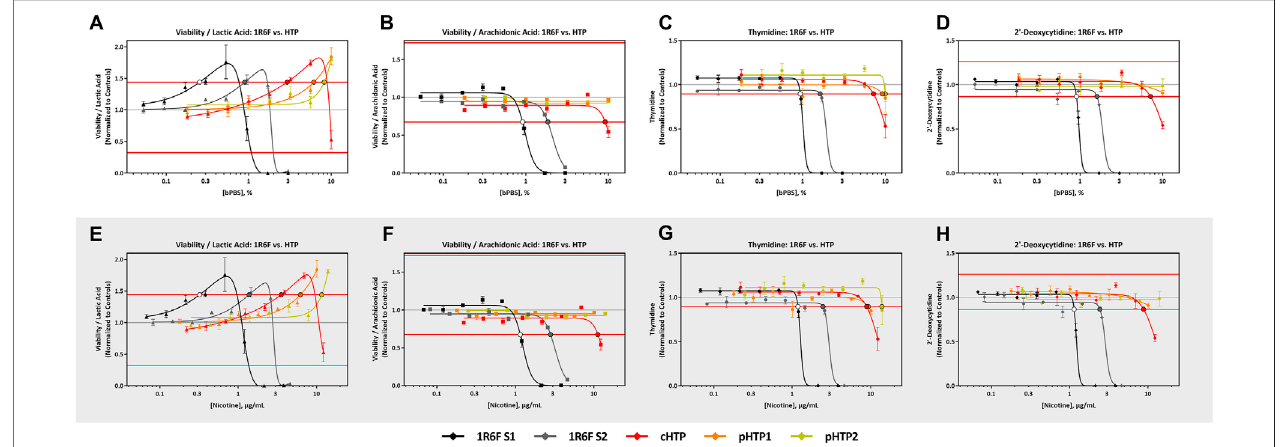
FIGURE 3 | 1R6F vs HTP Cell Viability/Lactic Acid, Cell Viability/Arachidonic Acid Thymidine, and 2 ′ -Deoxycytidine Response Comparison. The x-axis is the concentration (% bPBS) of the test article (A – D) or nicotine (µg/mL) (E – H) . The y-axes are the reference treatment normalized (fold change) values for each metabolite/ ratio. The horizontal red lines represent the metabolite-speci fi c prediction thresholds The black bordered circles represent the nicotine concentration where the dose- response curve crossed the metabolite-speci fi c prediction threshold.